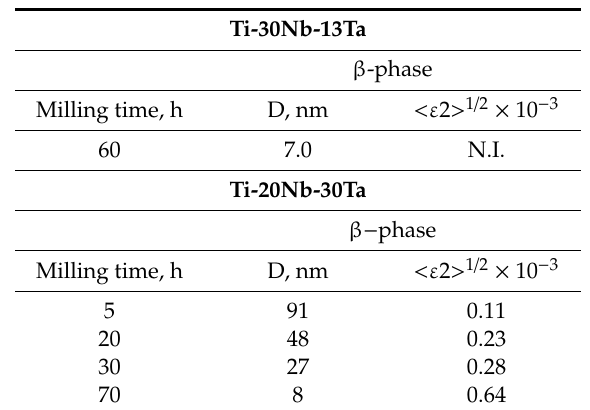
Table 2. Microstructural parameters as a function of milling time for the Ti-30Nb-13Ta alloy [32] and the Ti-20Nb-30Ta alloy adapted from [51].